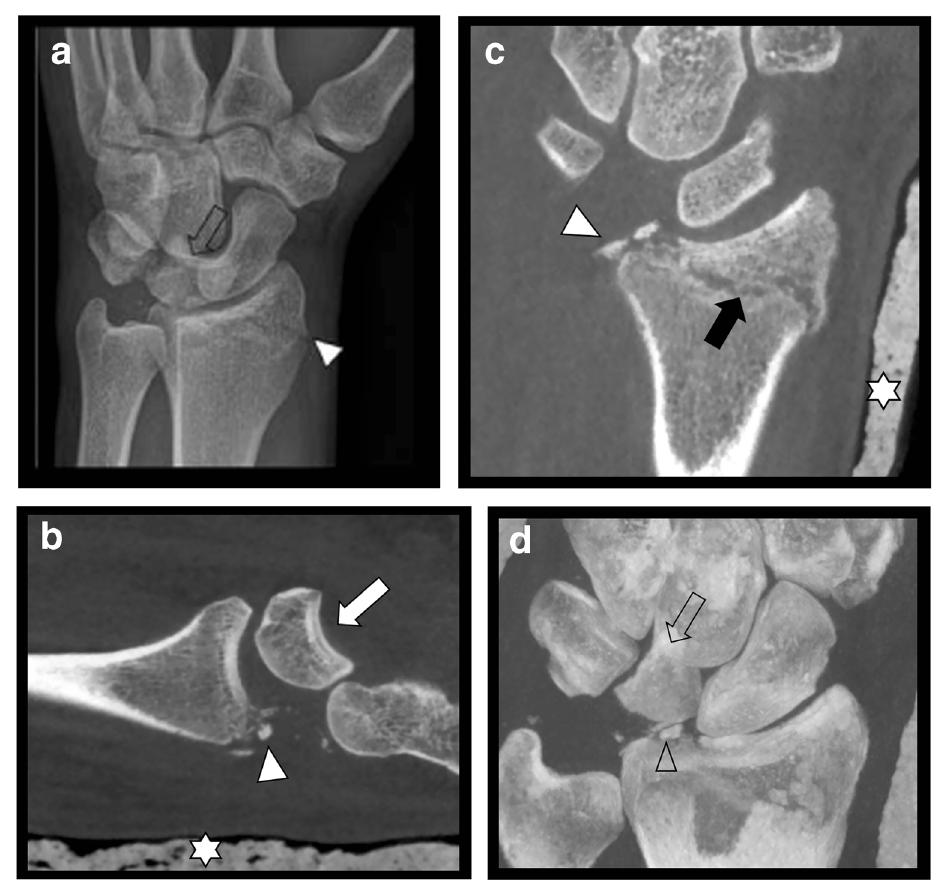
Fig. 5 Complex fracture of the dorsal side of the styloid process of the radius with intra-articular involvement, multiple intra- articular fracture fragments and perilunate dislocation. a . CR (oblique view) shows a fracture of the distal radius (arrowhead) and perilunate dislocation (arrow). b . Sagittal CBCT reformatted image after immobilization and casting (stars) shows residual perilunate dislocation (white arrow) with dorsal displacement of the distal carpal row and additional fracture fragments (arrowhead). c . CoronalCBCTreformatted image after immobilization and casting (stars) demonstrates distal radius fracture (black arrow). The degree of communition and additional fracture fragments better seen than on plain films (arrowhead). d . 3-D reconstruction may be useful for evaluation of the displacement of the carpal bones (open arrow) and additional fracture fragments (open